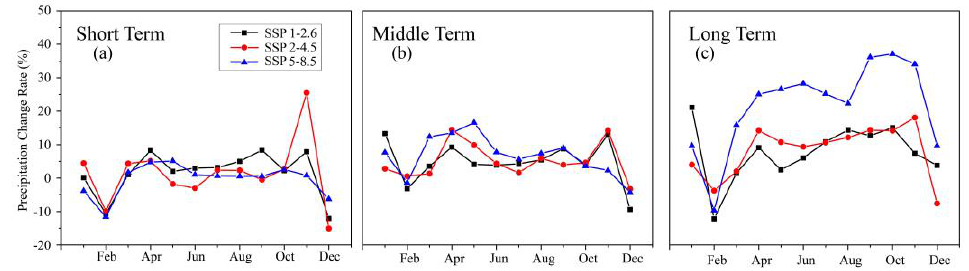
Figure 3. Average precipitation changes over the YZRB for the periods (2020–2040, 2040–2060 and